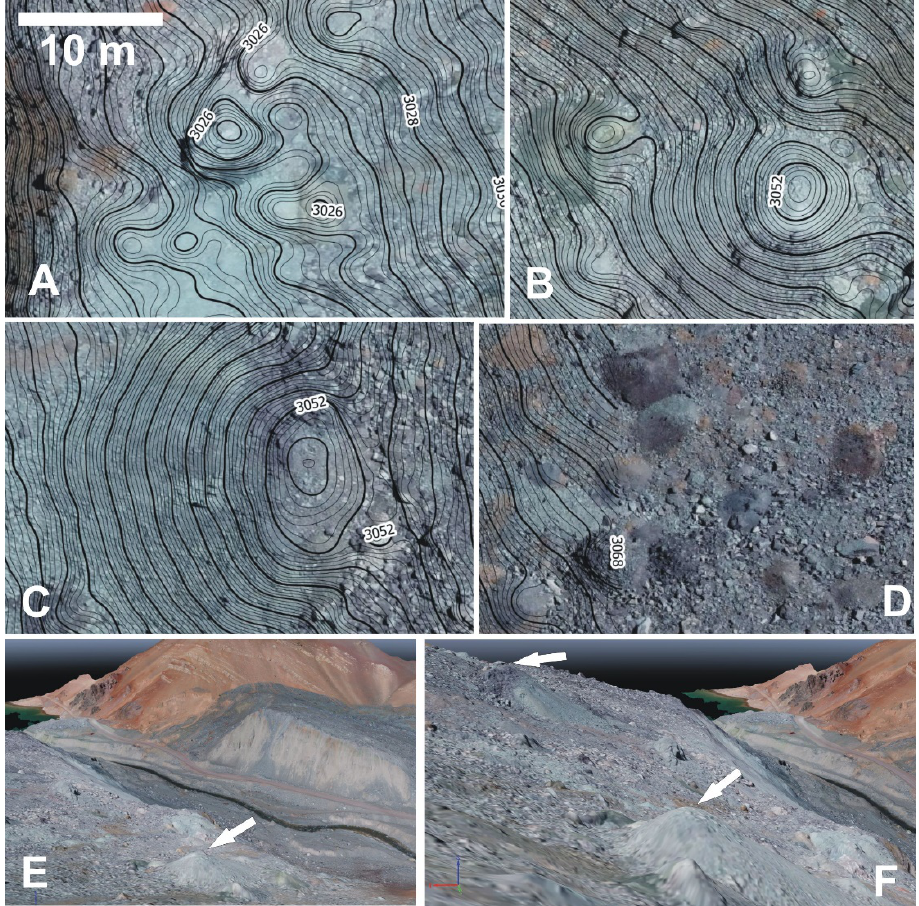
Figure 10. Detailed topography showing the 3D expression of molards. Location of ( A – D ) are shown in Figure 2. Main contours every 1 m, smaller every 20 cm. ( A ) Shows a rocky molard (centre of caption) that did not completely degrade into a cone. Note the slope change at the edge of the canyon and the easy identification of molards when they do not show chromatic contrast, as in ( D ). ( B , C ) Two of the largest molards that created colluvial microtalus aprons c. 10 m high downslope, and only 2 m up the general slope. ( D ) Caption at the limit of the survey showing a wide range of colours denoting a mixed composition of molards. ( E , F ) Virtual recreation of molards using the DEM and the surveyed photomosaic.